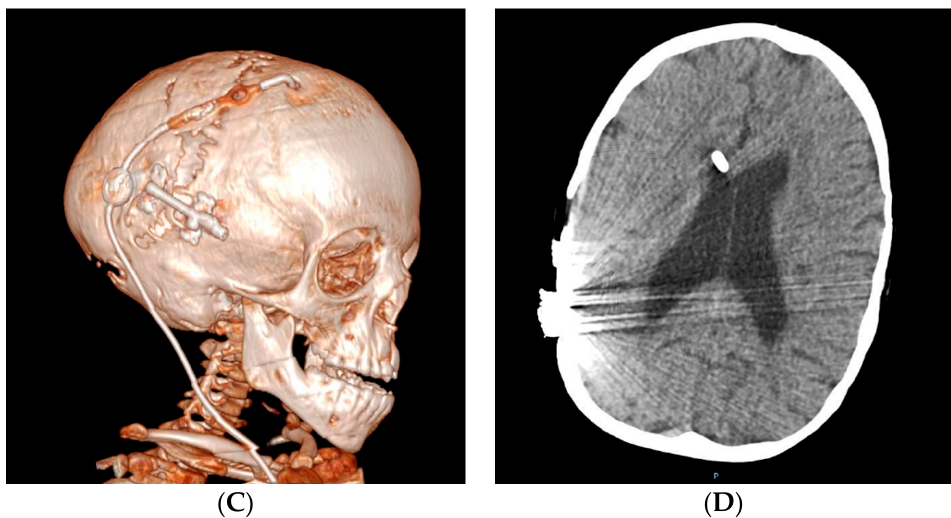
Figure 5. An 8-year-old patient with syndromic craniosynostosis and hydrocephalus, shunted at birth (also see Figure 3). Posterior cranial vault expansion by distraction osteogenesis performed before 1 year of age. The patient harbored an adjustable valve with FCD and in-line fixed antigravitational device. Episodes of headache and stiffness appeared, with slow valve refilling after pumping. ( A ) Ventricular collapse on MRI. ( B ) Improvement in ventricular size after shunt opti- mization (upgraded GV implanted in line) but symptoms only partially improved. ( C ) Re-do posterior cranial vault grad- ual distraction was performed with clinical and ( D ) significant radiological improvement.